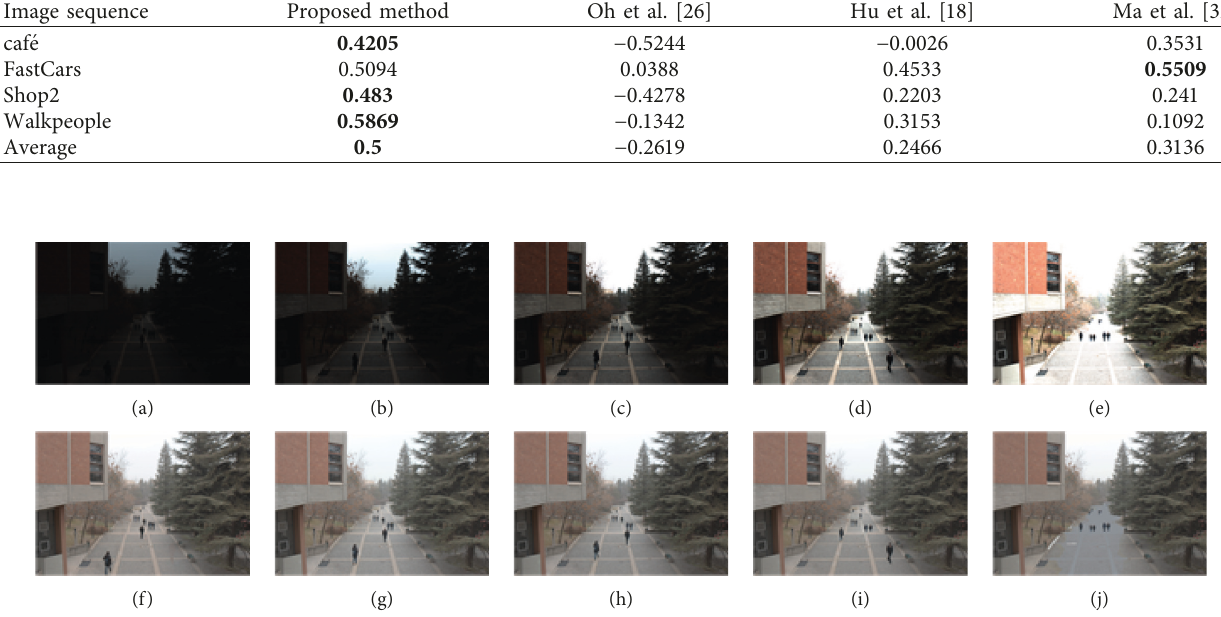
Figure 6: Comparison results of the proposed method with different reference image. (a–e) Input LDR images; (f–j) the results generated with (a–e) as the reference